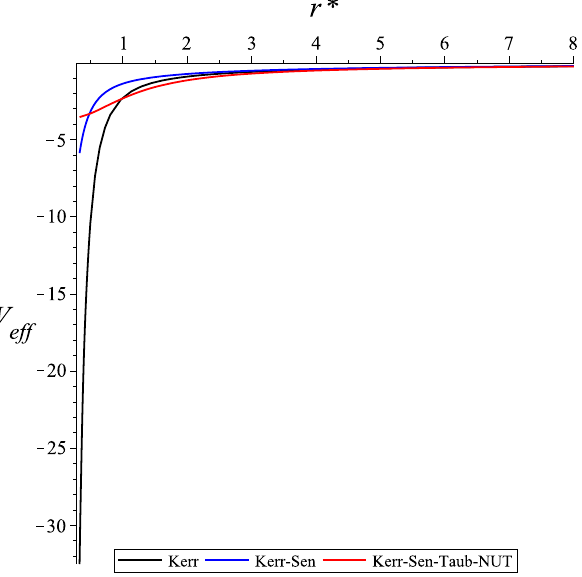
Fig. 2 Effectivepotentialsfortimelikeparticlewith E = 1and L ∗ = 1 around a collapsing mass with rotational parameter a ∗ = 0 . 5. The incorporated electric charge parameter b ∗ = 0 . 2, and NUT parameter l ∗ =